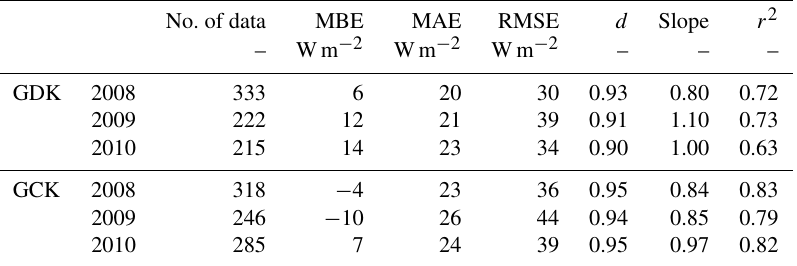
Table 1. Statistical parameters for the error assessment at the study sites. Mean bias error (MBE), mean absolute error (MAE), RMSE, and d indicate mean bias error, mean absolute error, root mean square error, and index of agreement, respectively. Slope and r 2 are from the linear regression analysis. No. of data MBE MAE